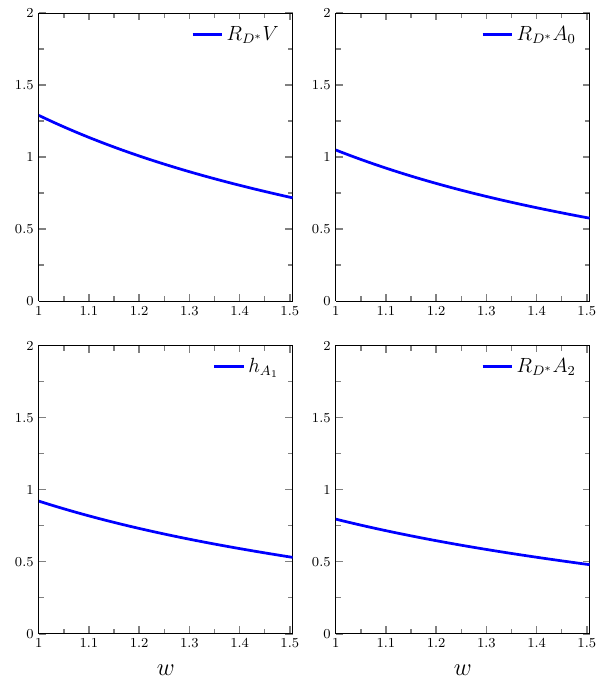
Fig. 9 the same as Fig. 8 but from Eqs. (46), (47) and (48) Ref. [9]) and also a different normalization at w = 1. The differences are not small, since the values of R i ( 1 ) in